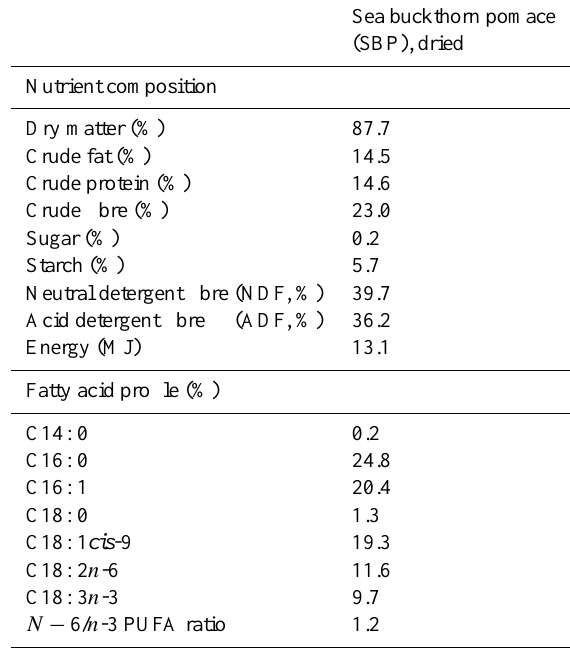
Table 1. Nutrient and fatty acid composition of dried sea buckthorn pomace (SBP).